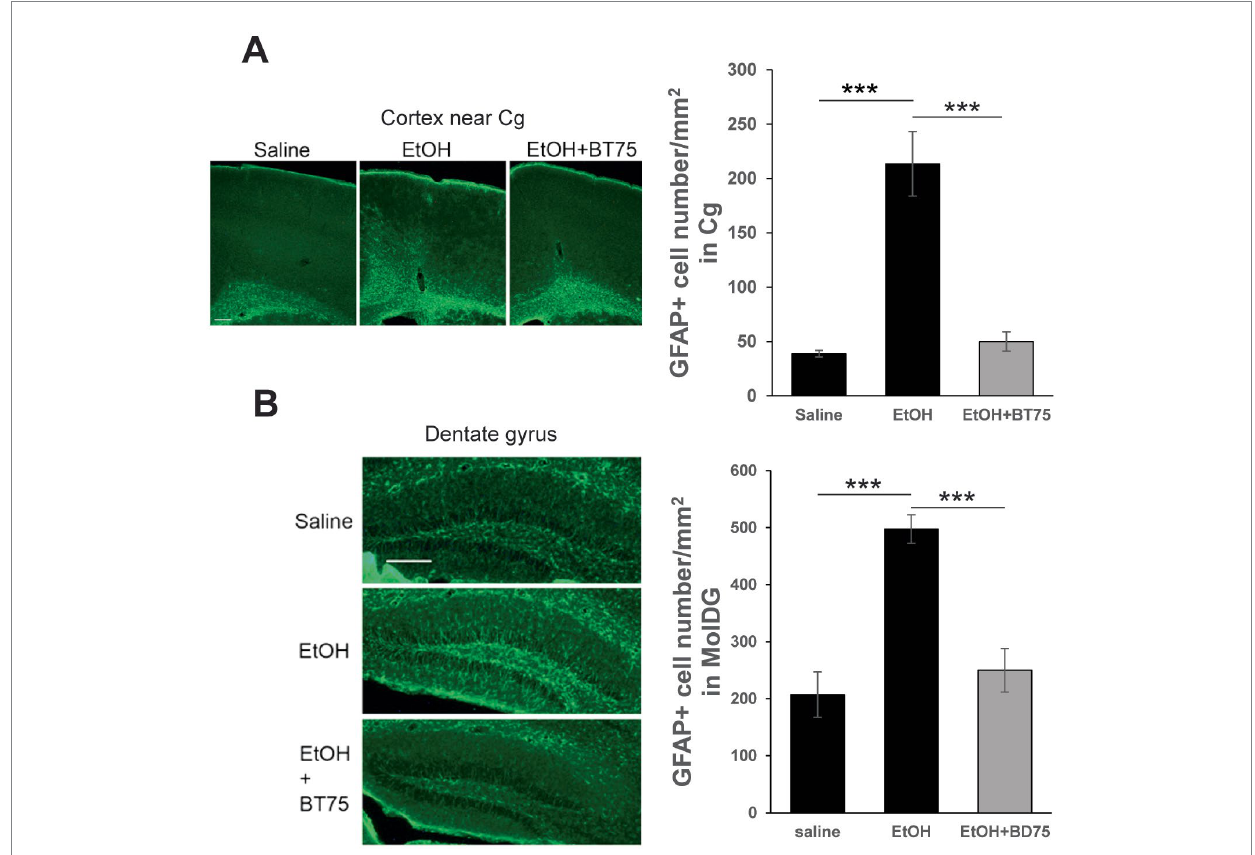
FIGURE 6 BT75 given before ethanol attenuates P7 ethanol-induced GFAP elevation at P60. (A) Mice were treated with BT75/vehicle and saline/EtOH at P7, and astrocyte activation was examined in the brain perfusion-fixed at P60. The brain sections were immunolabeled with anti-GFAP antibody. Scale bar = 200 μ m. GFAP+ cell number was counted in the cingulate cortex (Cg). *** p < 0.001 by Tukey test after one-way ANOVA. n = 4. (B) GFAP+ cell number was counted in the molecular layers of dentate gyrus. *** p < 0.001 by Tukey test after one-way ANOVA. n = 4. Scale bar = 200 μ